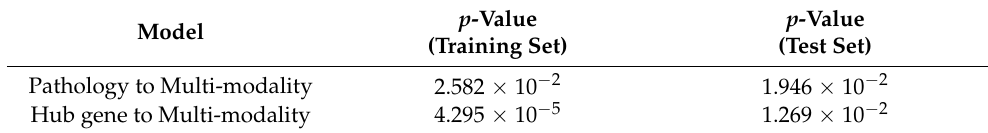
Table 3. C-index significant difference test between single-modality and multi-modality models.